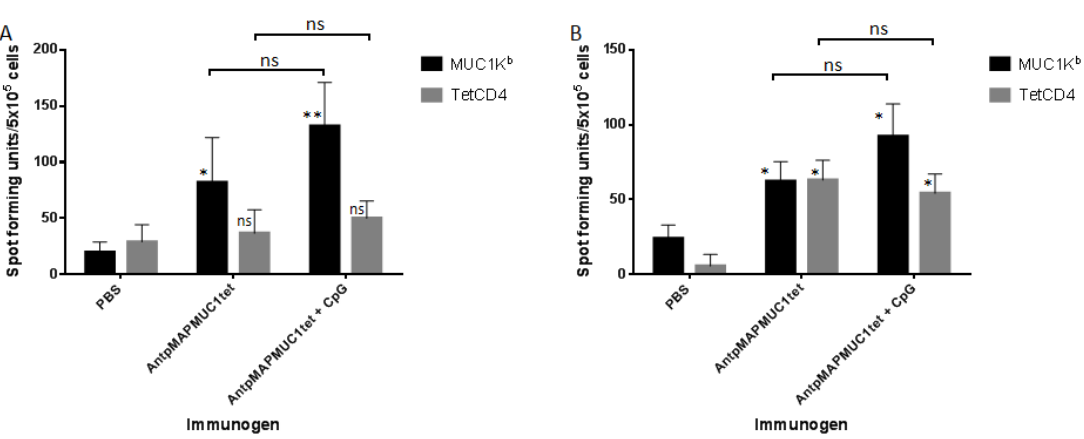
Figure 5. In vivo IFN-γ and IL4 response to AntpMAPMUC1tet and AntpMAPMUC1tet + CpG in C57BL/6. C57BL/6 mice were injected i.d. on day 0, 10 and 17 with PBS, 100 µg AntpMAPMUC1tet and AntpMAPMUC1tet + CpG. Number of IFN-γ secreting cells ( A ) and IL4-secreting cells ( B ) to MUC1K b (SAPDTRPAP) and tetCD4 antigens were analysed by ELISpot assay. ConA (1 µg/mL) was used as an internal positive control (not shown). Results are shown as mean spot-forming units (SFU)/5 × 10 5 cells ± SEM. Results are representative of three separate experiments. * p < 0.05, ** p < 0.001.